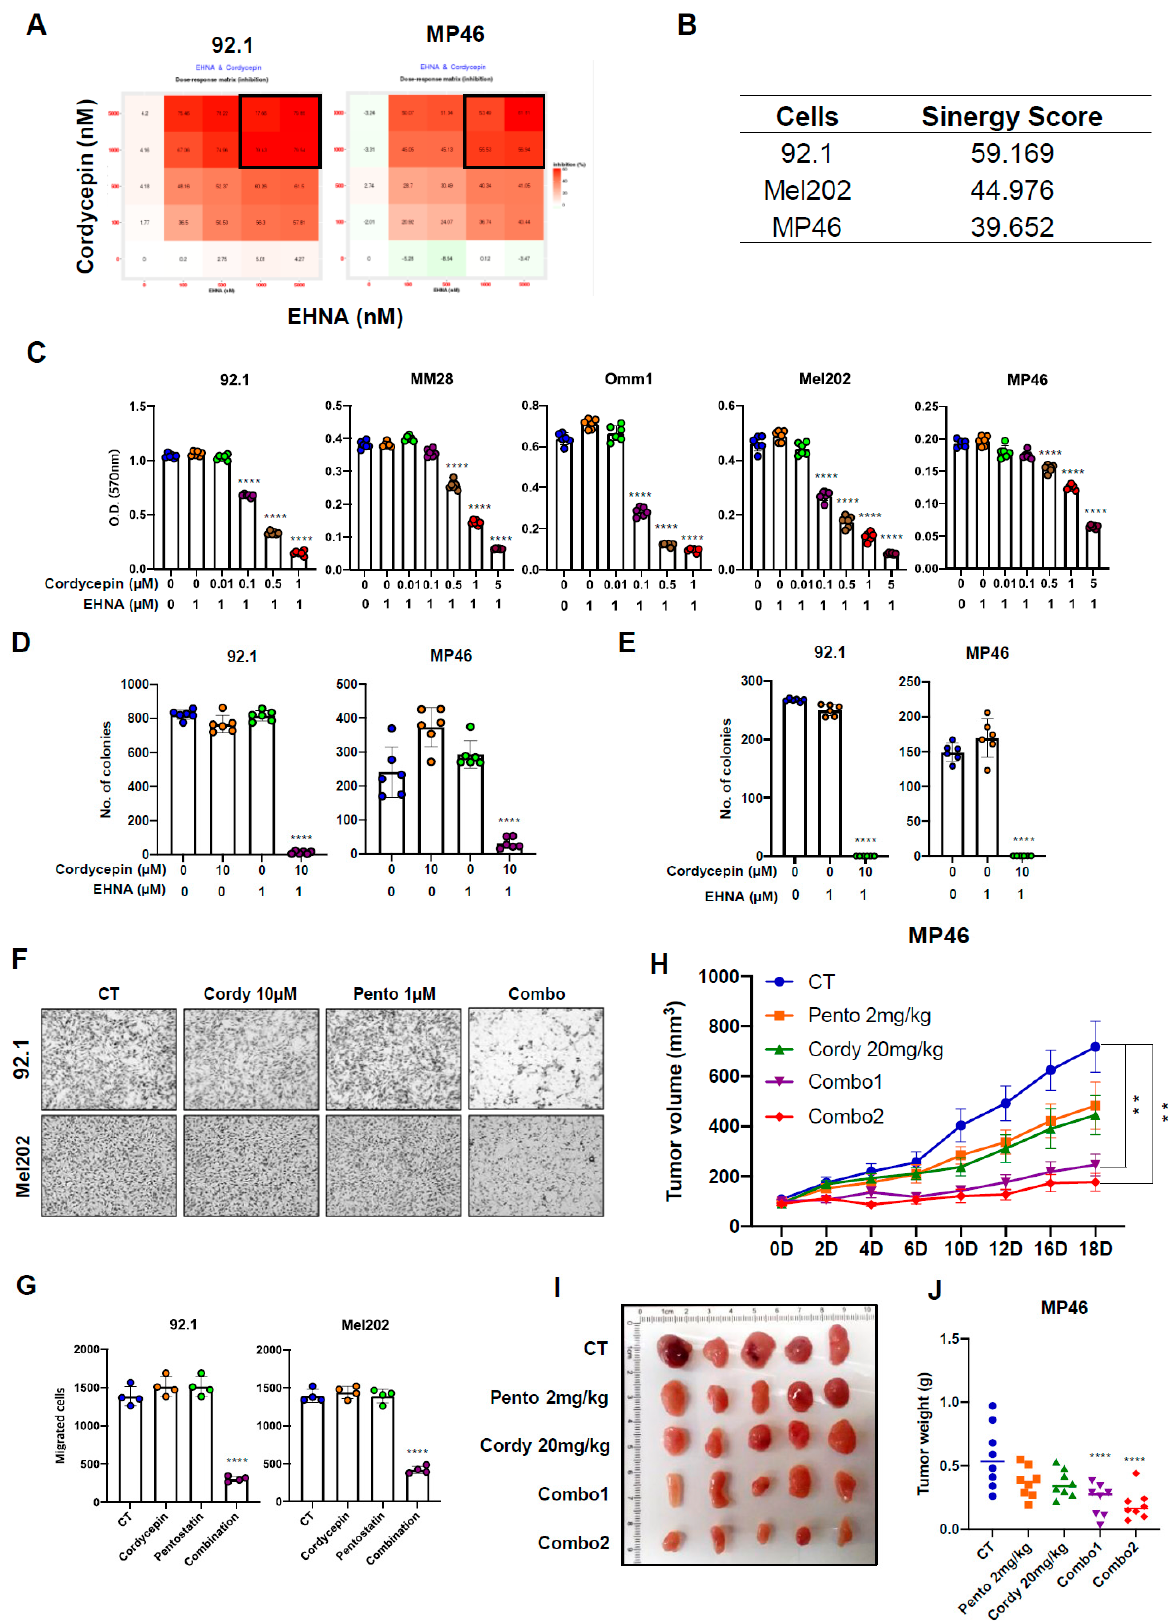
Figure 3. Targeting ADA synergistically enhances anticancer effects of cordycepin in uveal melanoma. ( A , B ) Synergistic effects ( A ) and scores ( B ) of cordycepin and EHNA in 92.1, Mel202 and MP46